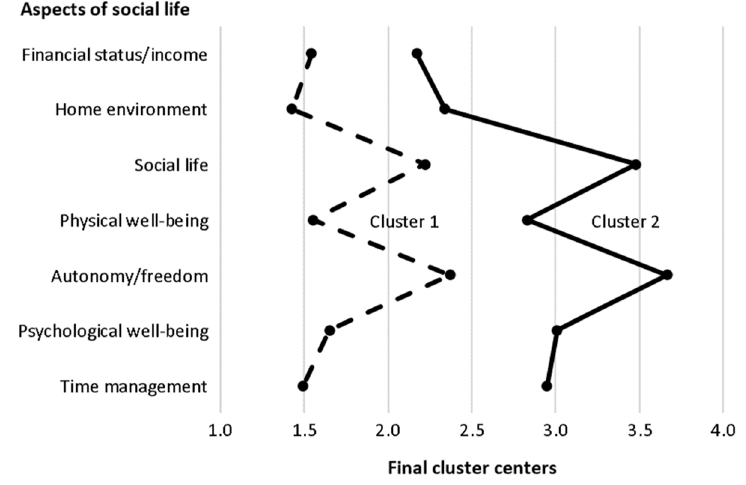
Figure 2. Profiles of the social impact of the lockdown on women. Note: The final cluster centers are computed as the mean for each variable within each final cluster; it reflects the characteristics of the typical case for each cluster in the chosen cluster solution.